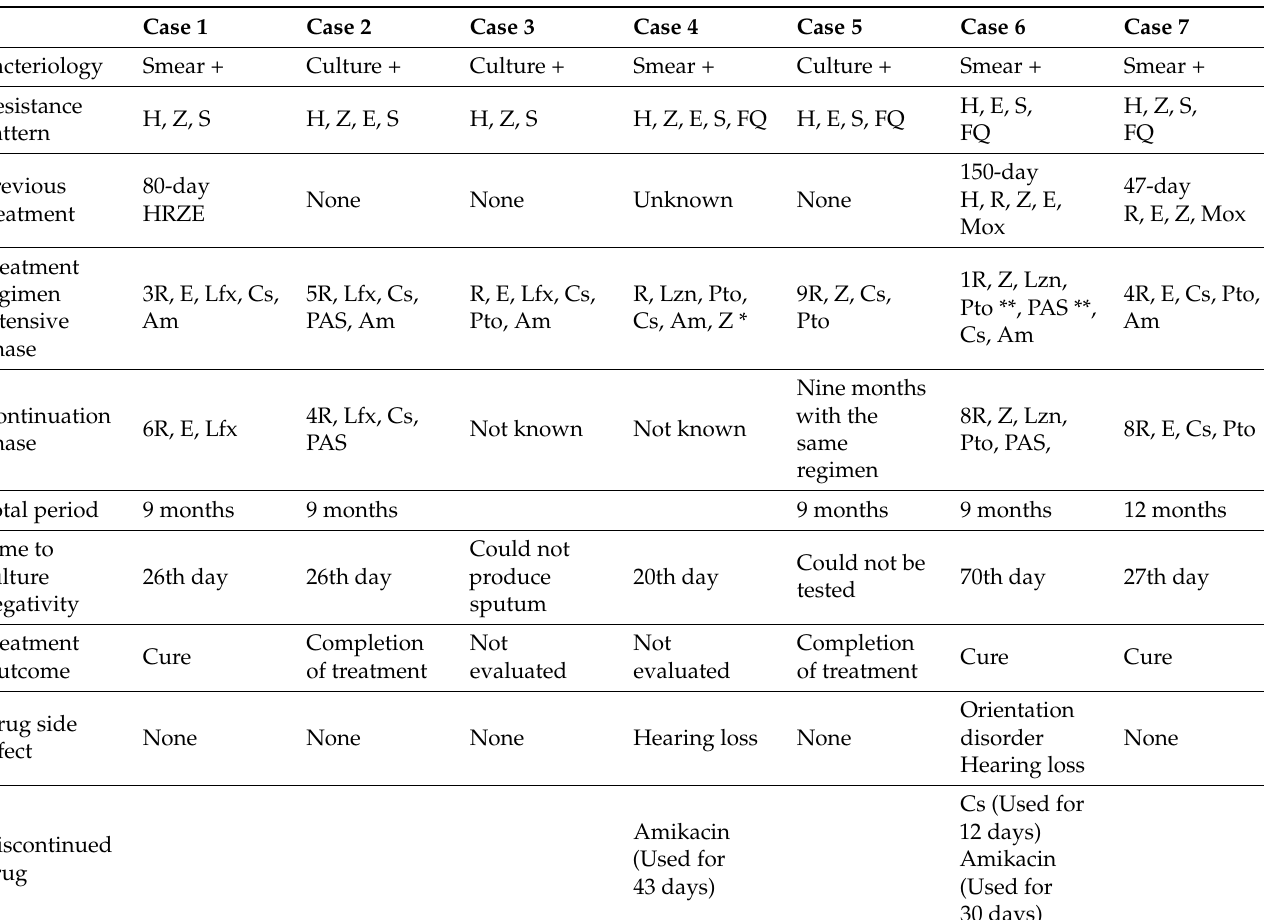
Table 2. Drug susceptibility testing results, applied treatment regimens, and outcomes of the polydrug-resistant TB